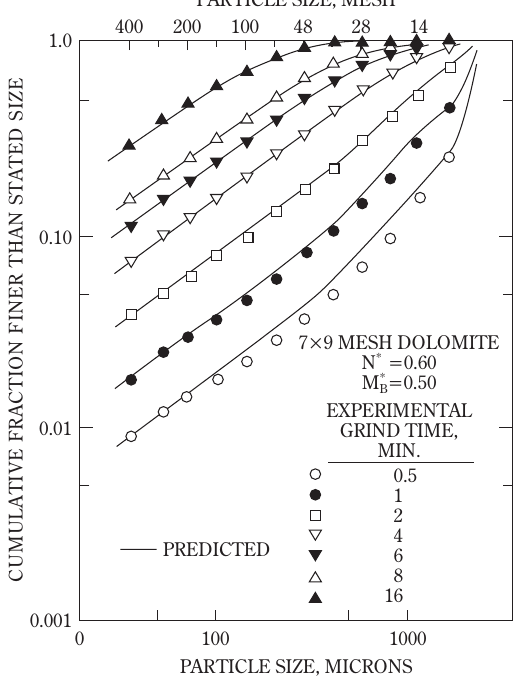
Fig. 2 Simulation of the comminution of 7 (cid:4) 9 mesh dolomite feed using the Batch grinding equation and the experimentally determined values of the breakage rate and breakage dis- tribution